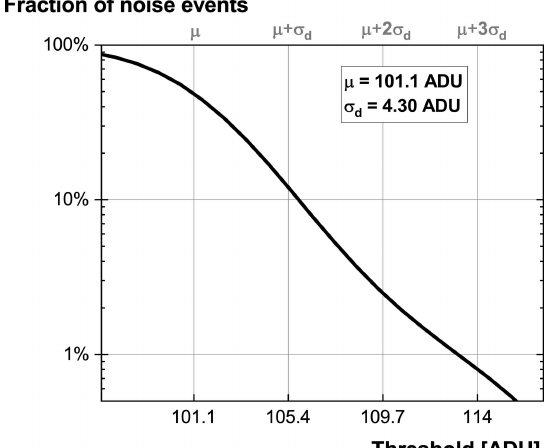
Figure 1 Noise distribution of the camera (operated in low noise mode) as a function of the applied threshold. The mean value (cid:3) and the standard deviation (cid:2) d are provided as scaling